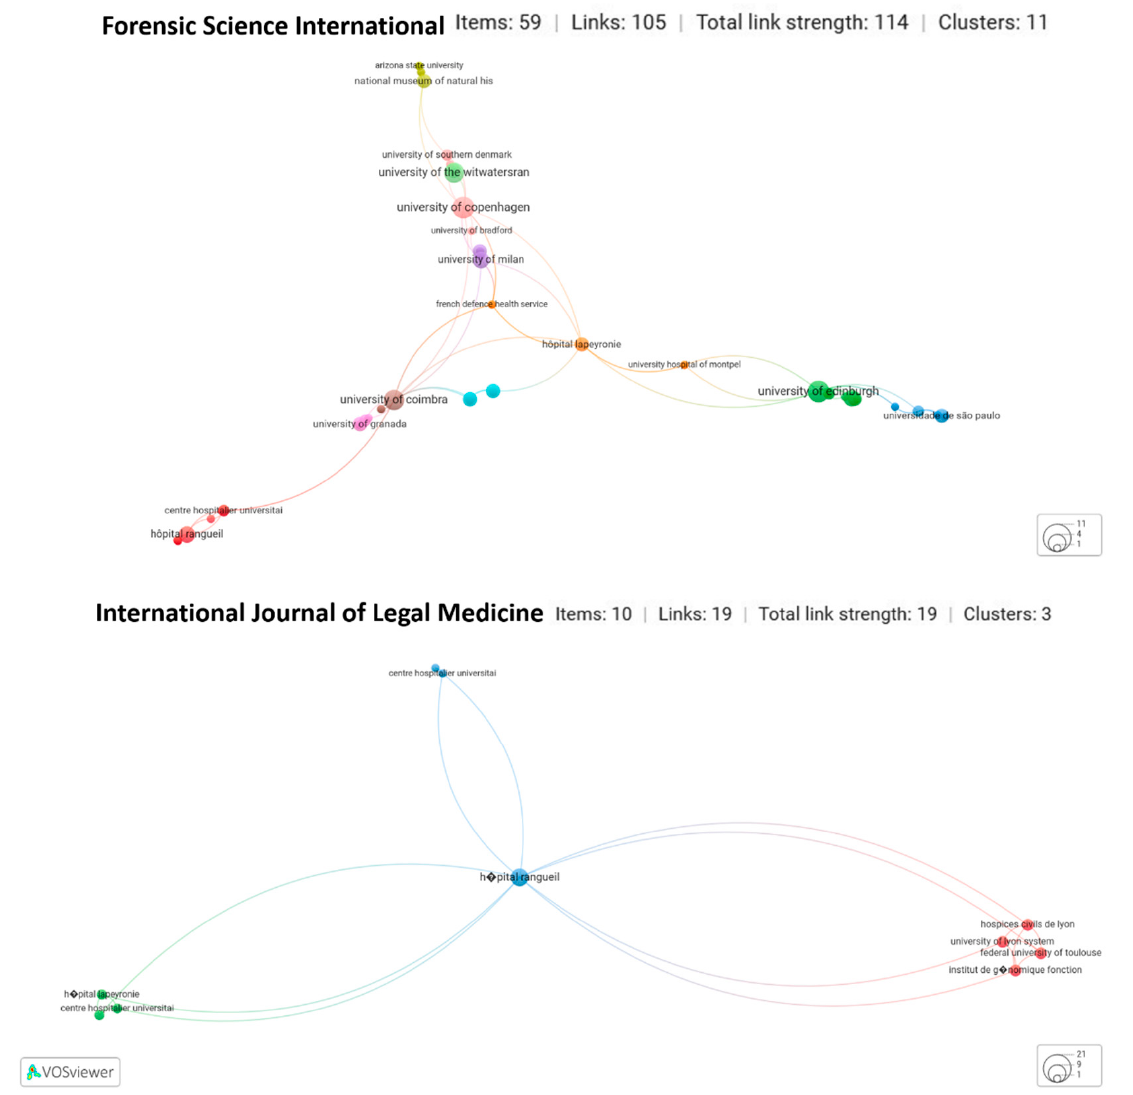
Figure 7. Network visualization of co-authorship by institutions for publications in the TOP4 journals. The interactable maps are accessible at: Journal of Forensic Sciences https://app.vosviewer.com/?json=https://drive.google.com/uc?id=1KwDJ4Ps_jf7yCejj1yfVZtkLub5TA2